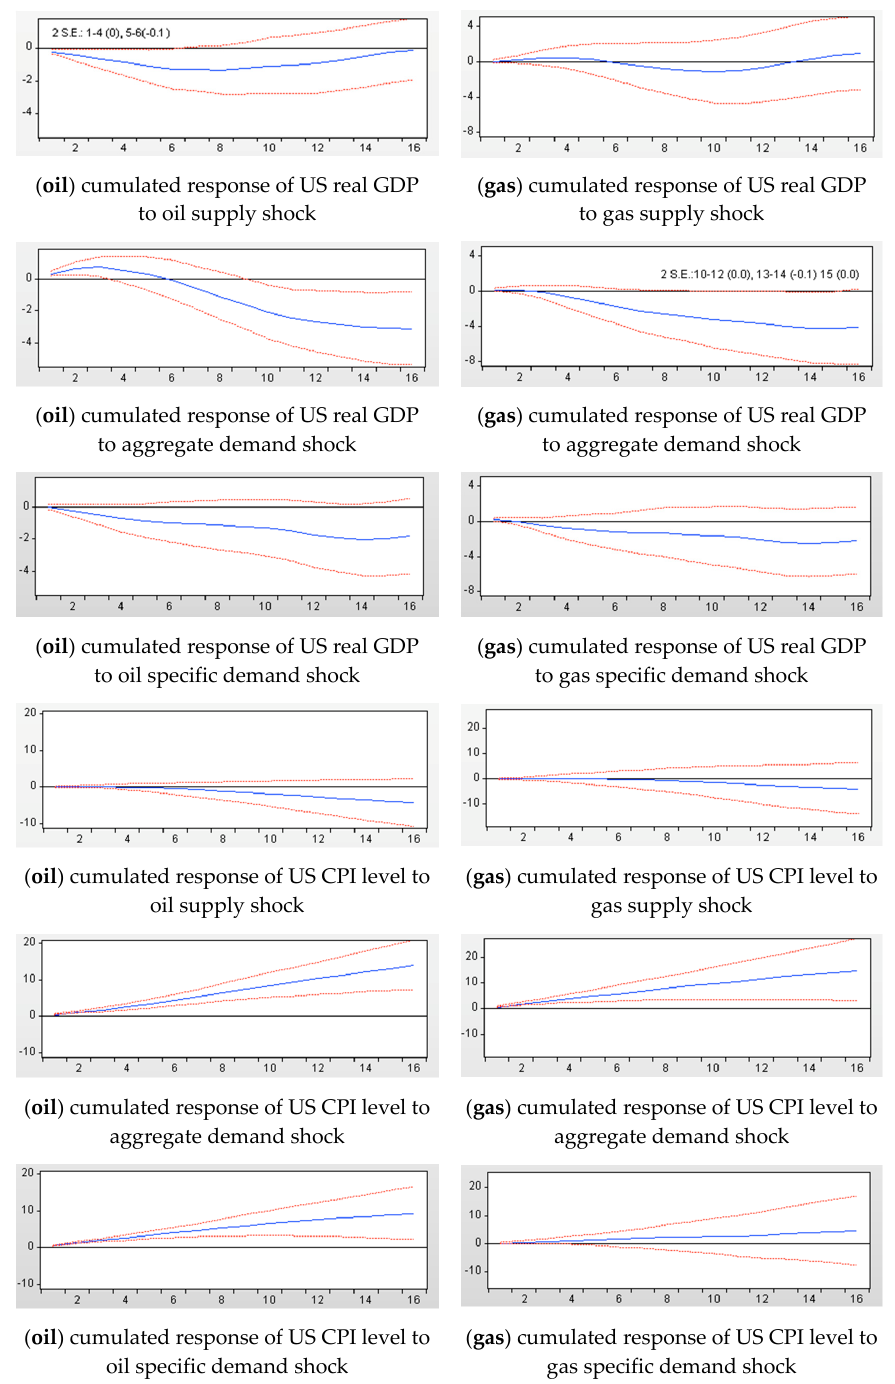
Figure 4. The responses of US real GDP growth and CPI inflation to each structural shock. Note: The plots show the cumulative responses, as estimated from the regression models.